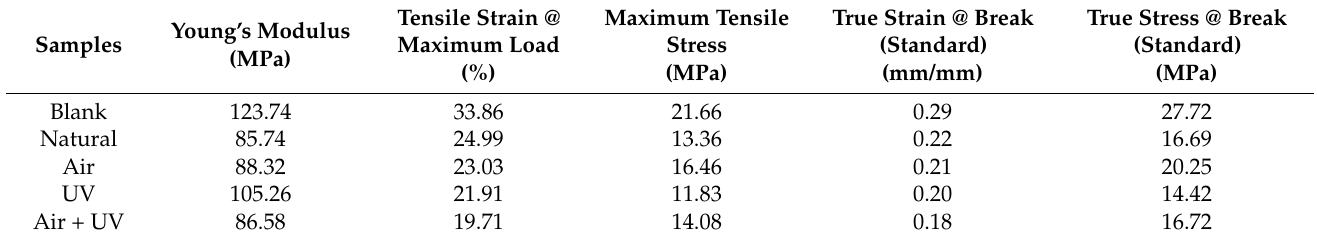
Table 2. Results of the mechanical properties of the PLA/PHB samples obtained from tensile